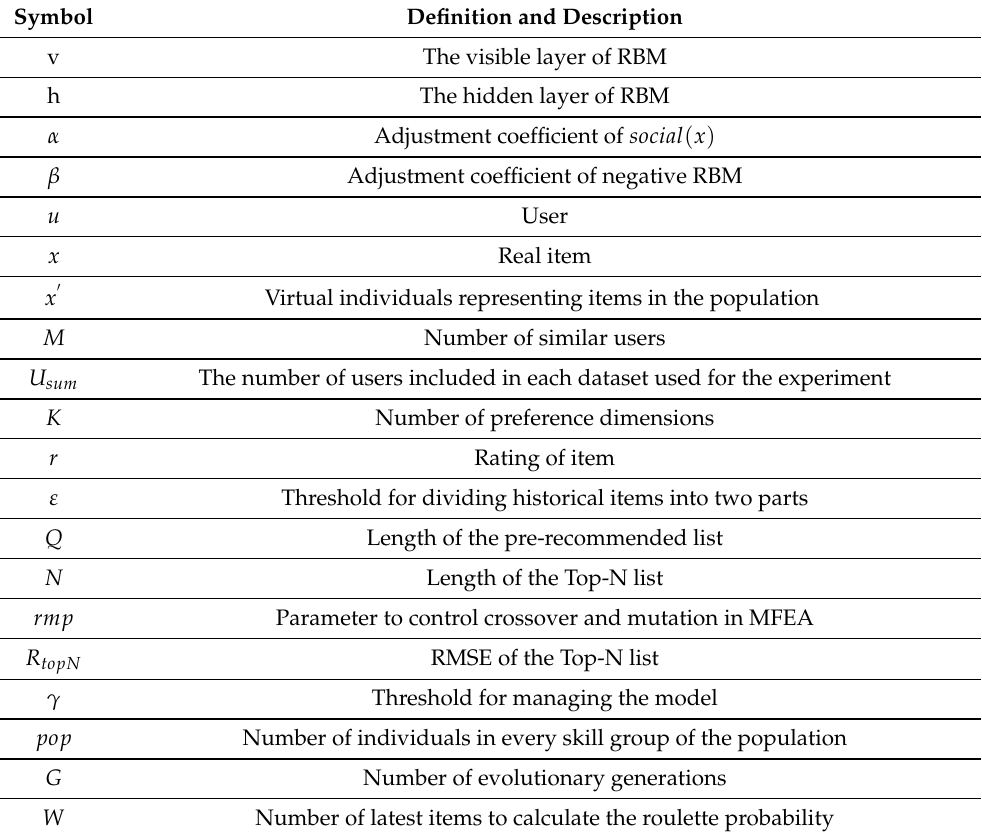
Figure 2. The framework diagram of the proposed MPUSMs-IMFEOA algorithm. Table 1. Annotation of the